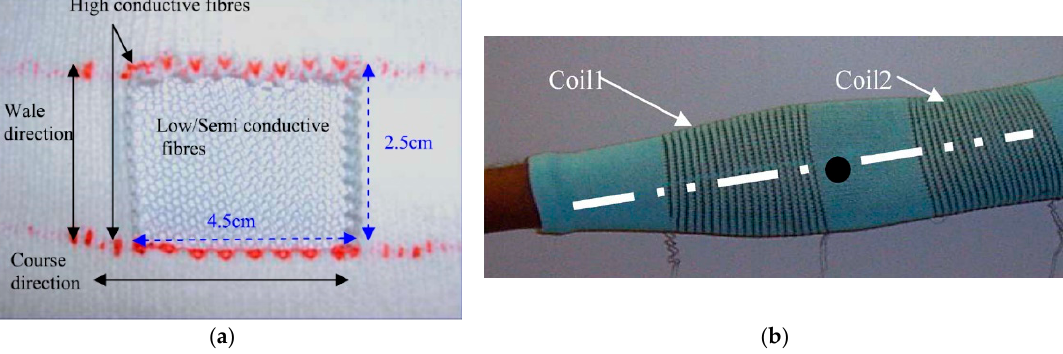
Figure 7. ( a ) Knitted sensor [35] ; ( b ) Knitted coil sensors in arm sleeve [46] .